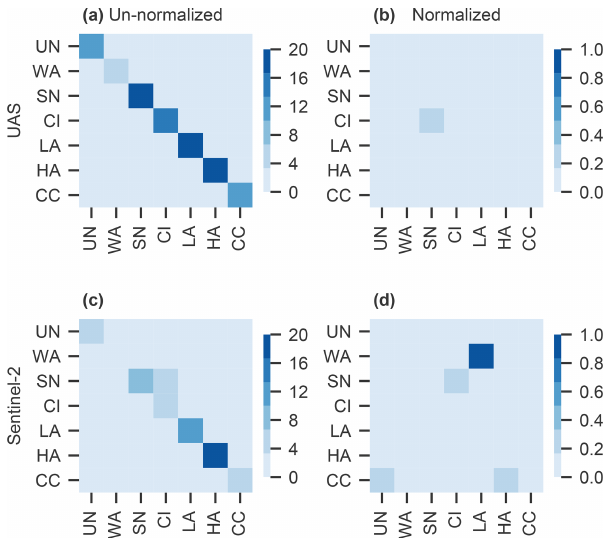
Figure B1. Confusion matrices and normalized confusion matri- ces for the random-forest models applied to the UAS (a, b) and Sentinel-2 (c, d) data. Confusion matrices show predicted class on y axis and actual class on x axis. The scores at the intersections show the frequency of instances.